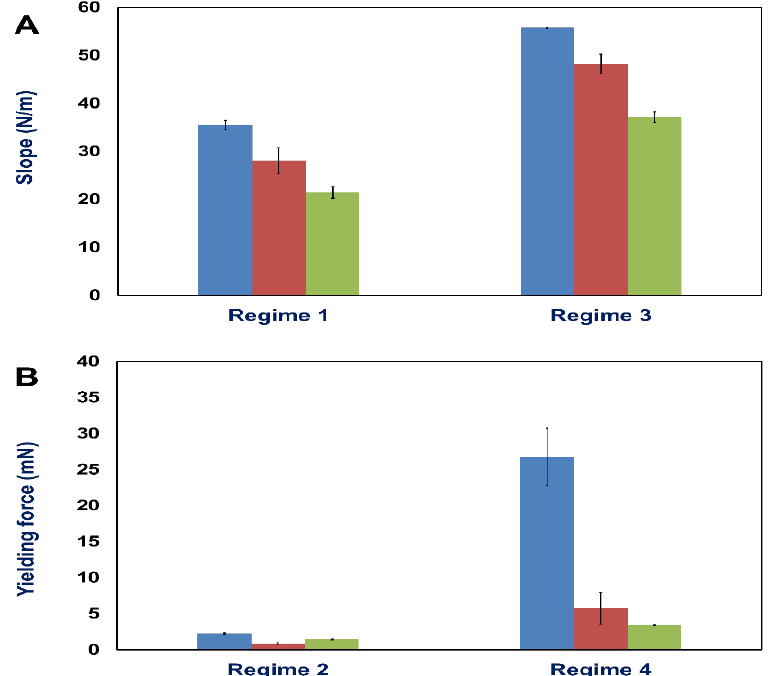
Figure 3. ( A ) Slopes of force-distance curves within regime 1 (elastic constants) and regime 3; and ( B ) yielding forces (maximum forces) at the beginning of regime 2 and 4 for different displacement rates: 0.1 µm/s (blue), 0.5 µm/s (orange), and 2.0 µm/s (green). The numbers give mean values and standard deviations (SD).